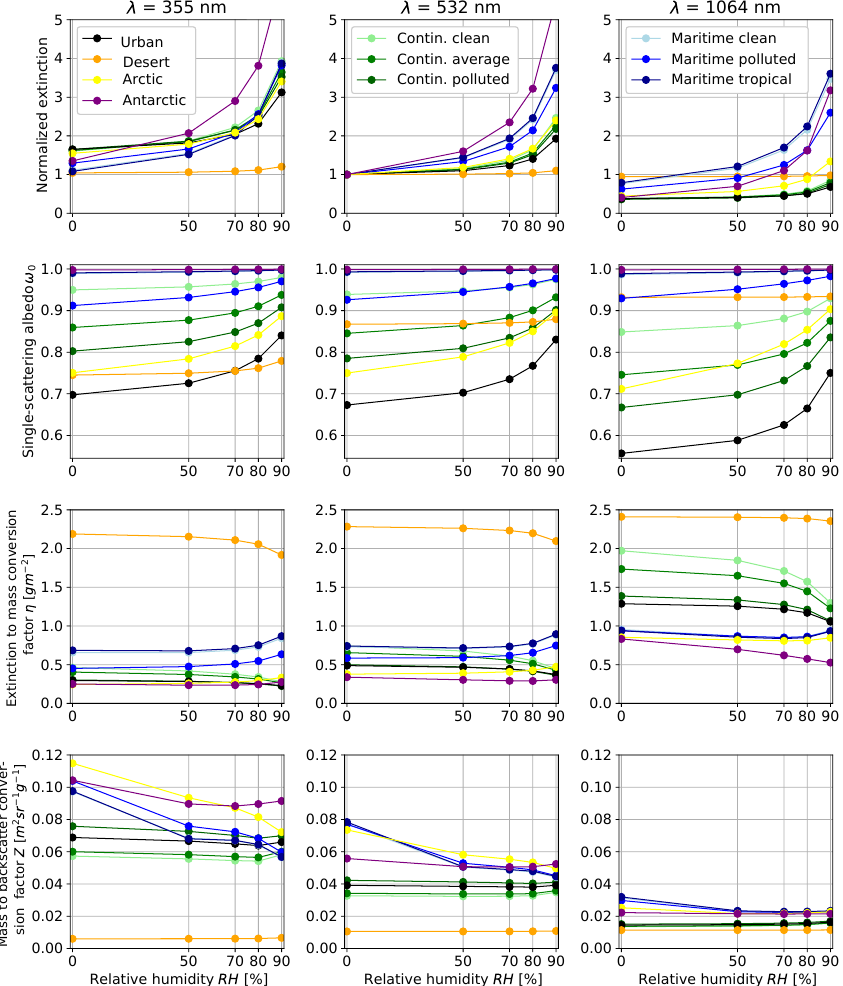
Figure 5. Properties of OPAC aerosol types as a function of relative humidity RH calculated with the κ parameterization (Zieger et al., 2013) implemented in MOPSMAP (Eq. 21). The different colors denote the 10 different OPAC aerosol types as indicated in the legends. The columns denote different wavelengths λ as indicated above the upper row. The upper row shows the extinction coefficient normalized to the extinction coefficient of the same aerosol type at RH = 0% and λ = 532nm. The single-scattering albedo ω 0 , the extinction-to-mass conversion factor η , and the mass-to-backscatter conversion factor Z are plotted in the subsequent